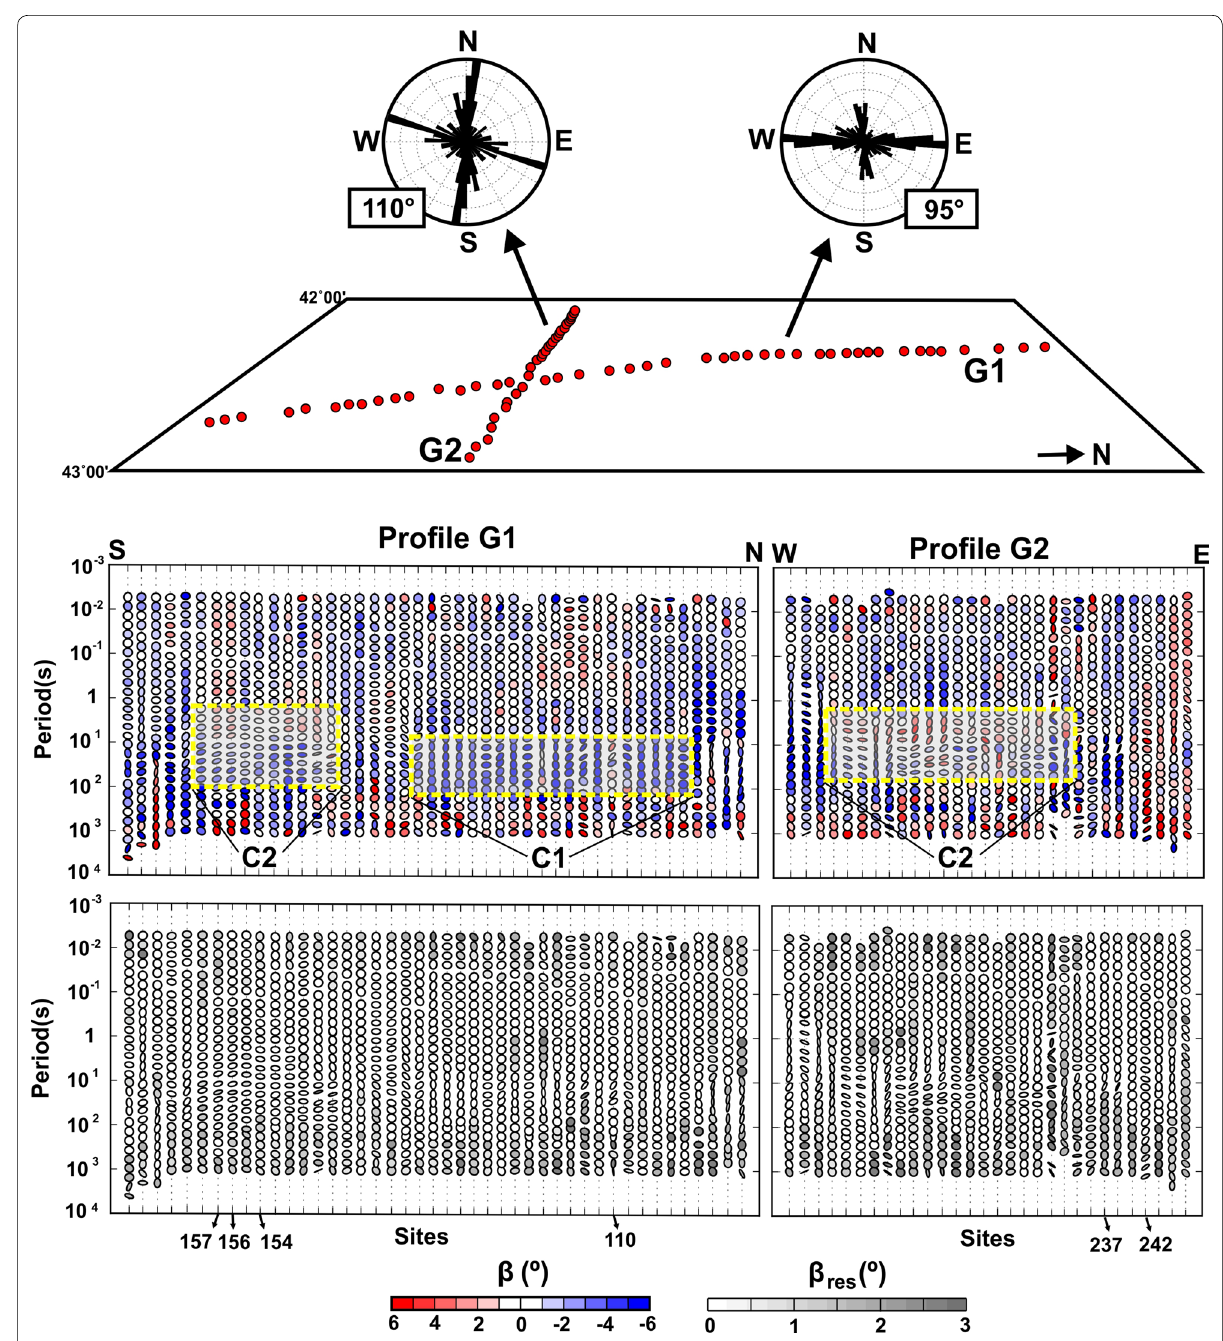
Fig. 3 Geo-electric strike directions and phase tensor ellipses for the whole data. Strike directions obtained by phase tensor analysis are shown as rose diagrams. The resolution of rose diagrams is 5 degrees. The phase tensor ellipses which are normalized by the major axes are filled with the skew angle ( β ) and residual of the skew angles ( β res ). The yellow rectangles indicate high beta values, and ellipticities attributed to the mid-to-lower crustal conductive zones (C1 and